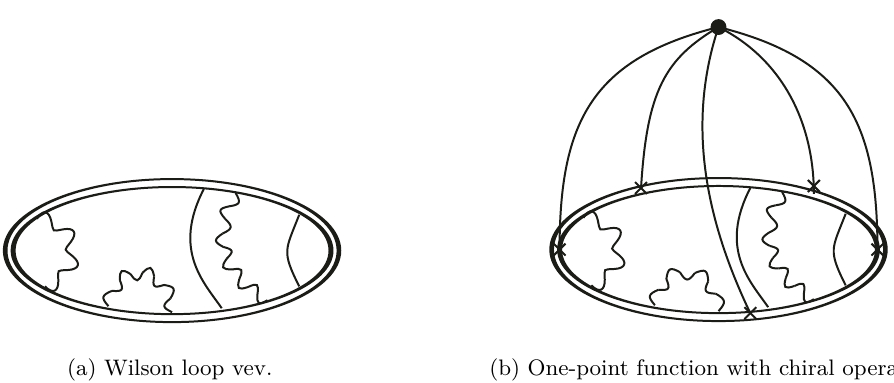
Figure 3 . Typical diagrams contributing to h W i and h WO ~n i in the N = 4 theory. The double line represents the Wilson loop, the wavy line is the gauge field, while the straight line stands for the scalar field in the Wilson loop